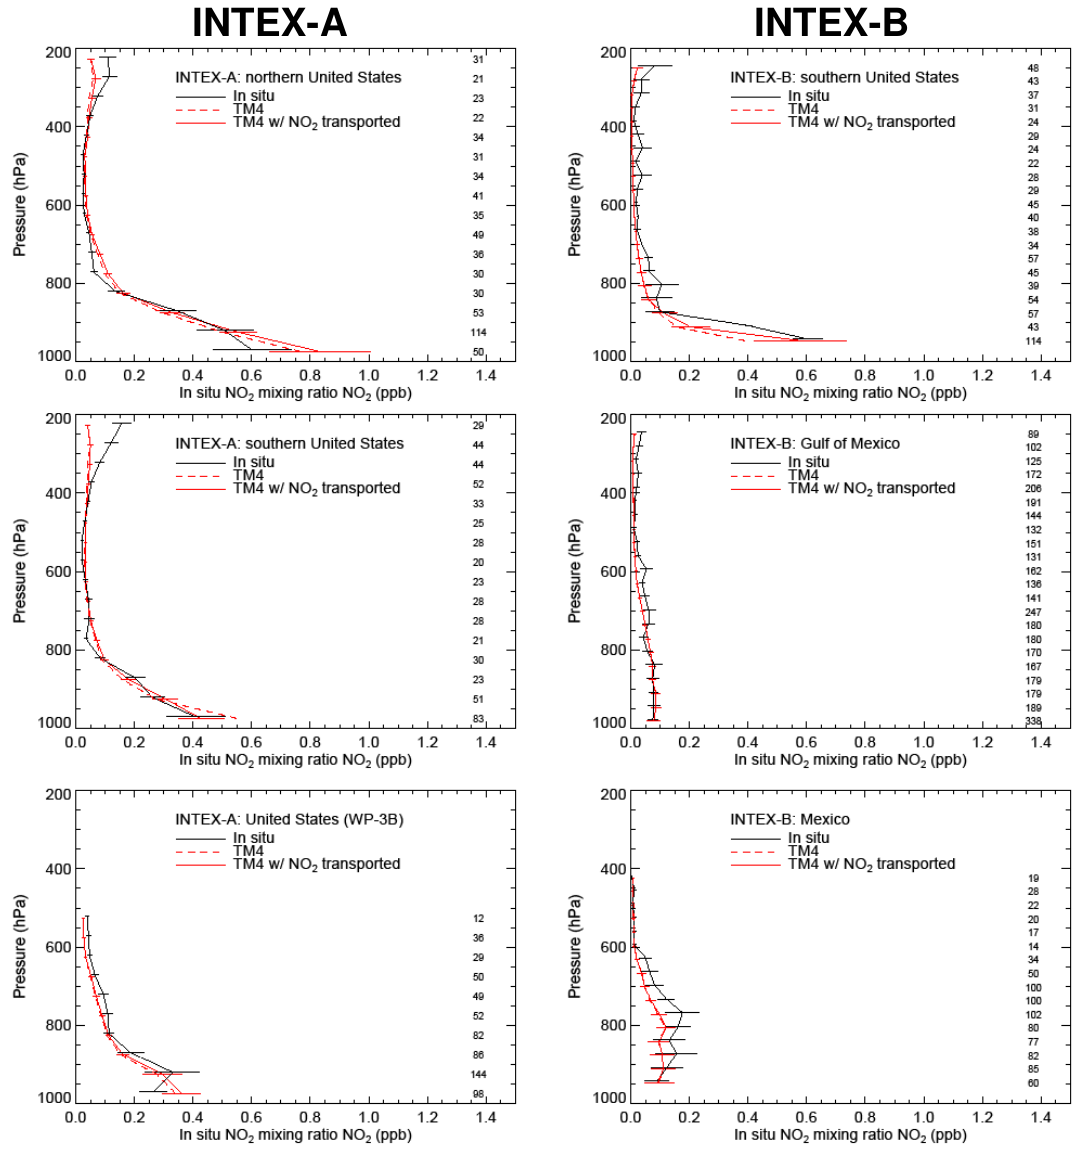
Fig. 6. Vertical profiles of NO 2 averaged over the INTEX-A/ICARTT (July–August 2004) and INTEX-B (March 2006) periods over the northern United States (100 ◦ W–87 ◦ , 34 ◦ N–46 ◦ N), the southern United States (100 ◦ W–87 ◦ , 28 ◦ N–34 ◦ N), the Gulf of Mexico (97 ◦ W–86 ◦ , 20 ◦ N–27 ◦ N), and Mexico (100 ◦ W–97 ◦ , 18 ◦ N–26 ◦ N) averaged over the INTEX-B period. The comparisons exclude strongly local- ized and recent pollution as diagnosed by NO x /NO y > 0.4 or NO 2 < 4ppb. The black and red lines represent the average profiles from the in situ measurements and the TM4 model, respectively. The error bars represent the standard deviations divided by √ n .